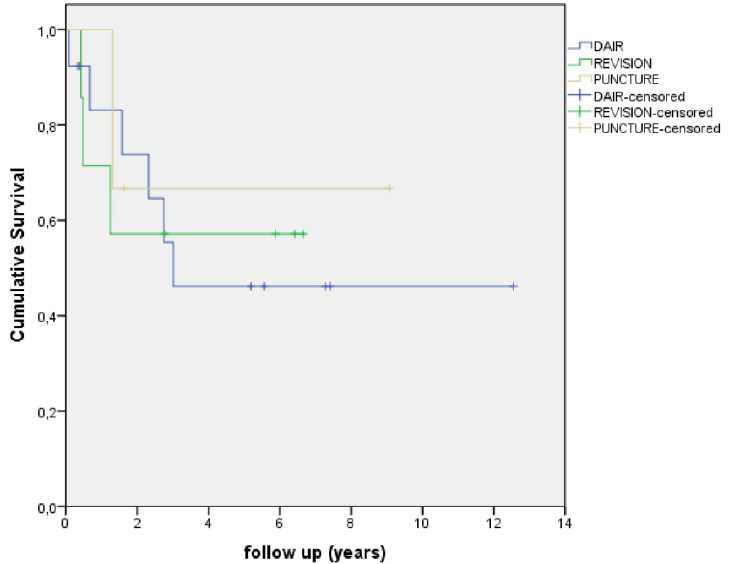
Figure 5. Kaplan-Meier curve showing survival/time without an event, DAIR vs Revision vs Puncture. DAIR: Debridement, Antibiotics and Implant